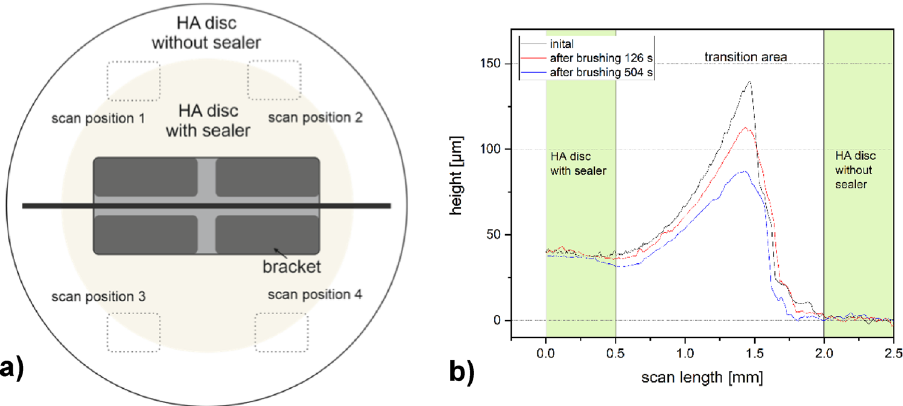
Figure 2. ( a ) Schematic drawing of a hydroxyapatite disc including the measuring positions. ( b ) Example of a profile image determined by mechanical